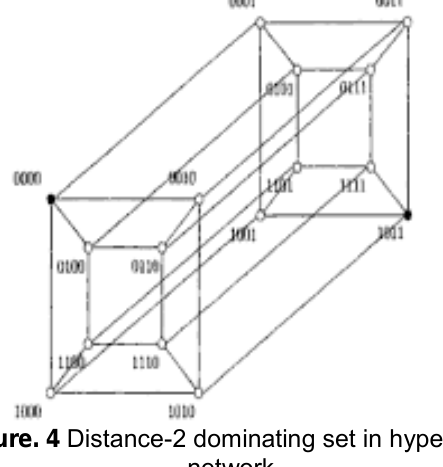
Figure. 4 Distance-2 dominating set in hypercube